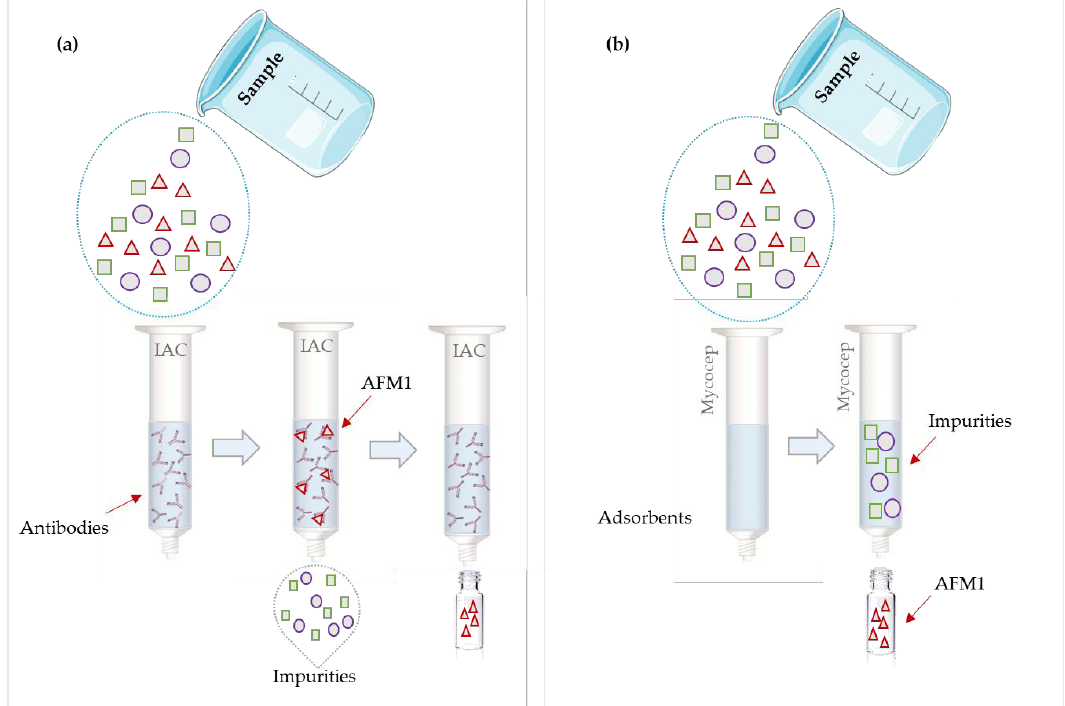
Figure 3. ( a ) Scheme of immunoaffinity column ( b ) Scheme of Mycosep TM .